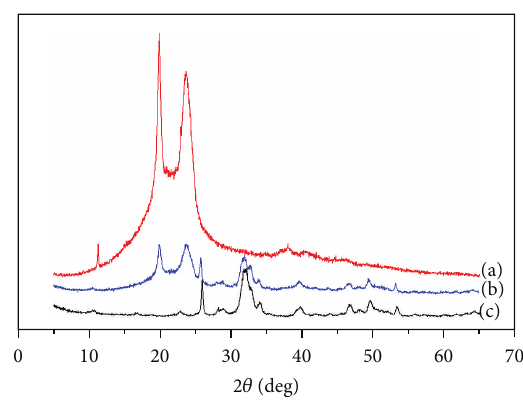
Figure 2: The XRD patterns of PA (a), s-HA/PA composite (b), and s-HA (c).